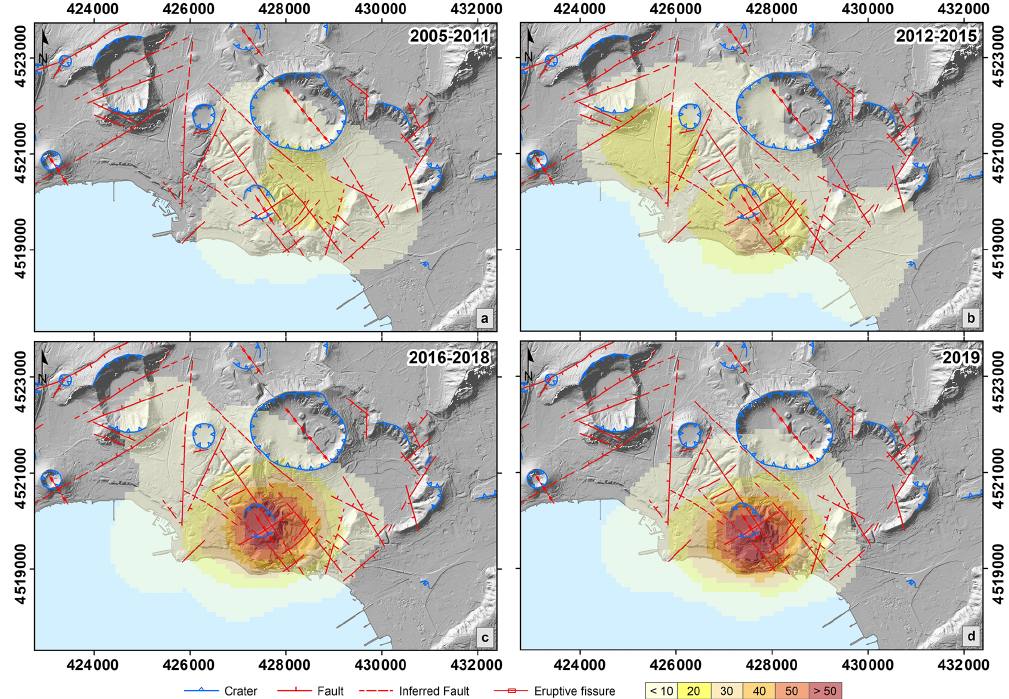
Figure 8. Density of CF-swarms from 2005 to 2019: (a) from 2005 to 2011, (b) 2012–2015, (c) 2016–2018, and (d) 2019. DTM and morphostructural map of Campi Flegrei (Vilardo et al., 2013). Reference system UTM WGS84.